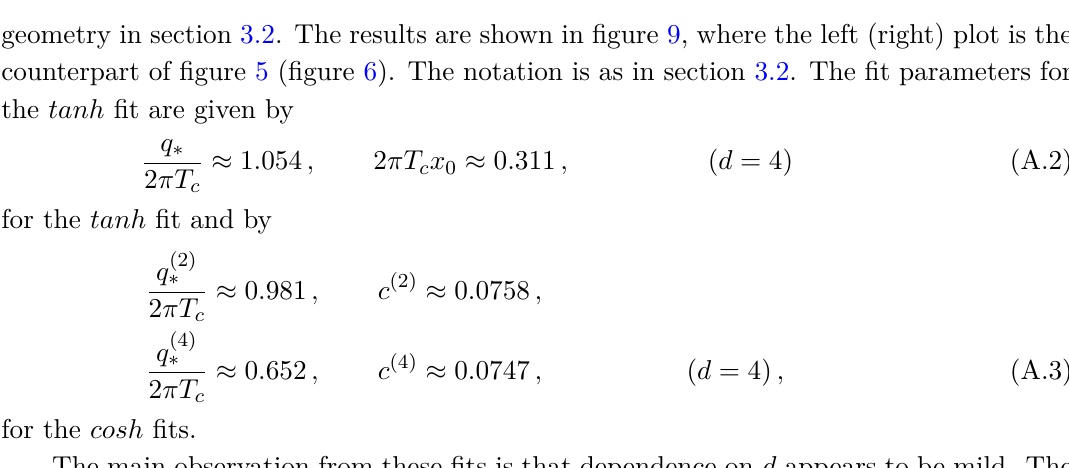
Figure 9 . Fitting of the (normalized) components of the energy-momentum tensor for the six- dimensional geometry. Left: tanh fit to ˆ T and to ˆ T . Blue dots show the energy-momentum ττ φφ tensor extracted from the numerically constructed geometry of [20], and the green curves are given by the fit in equation (3.12). Right: fits to ˆ T . The green curve is the prediction from the fit of yy figure 5, given in equation (3.15). The dashed magenta and dot-dashed red fits were obtained by using the former and latter formulas of equation (3.16),